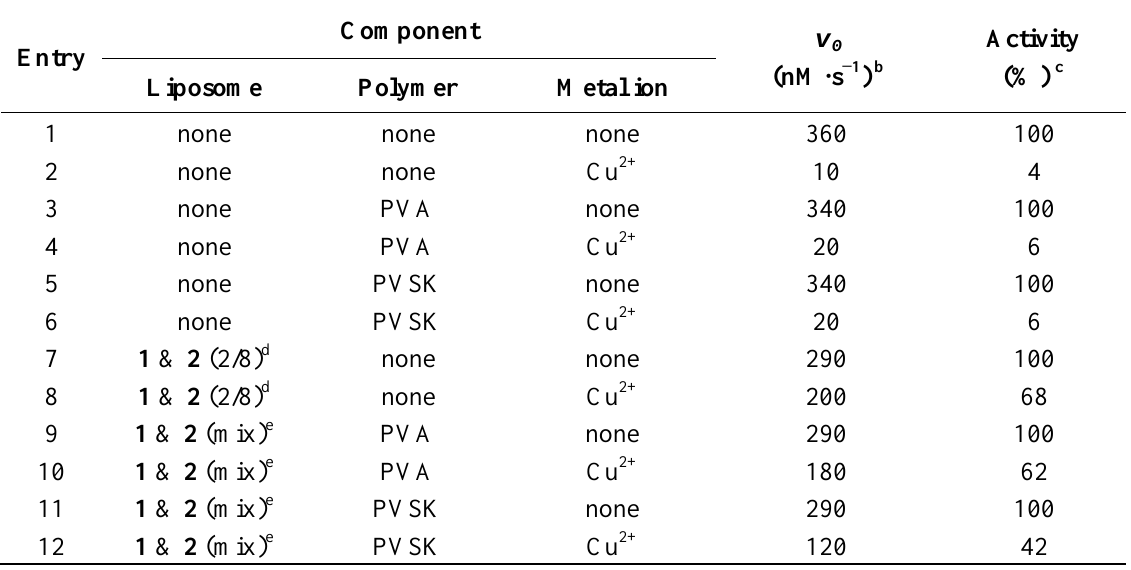
Table 1. Enzymatic activity on liposomes in HEPES buffer (10 mM) at pH 7.0 and 35 °C a